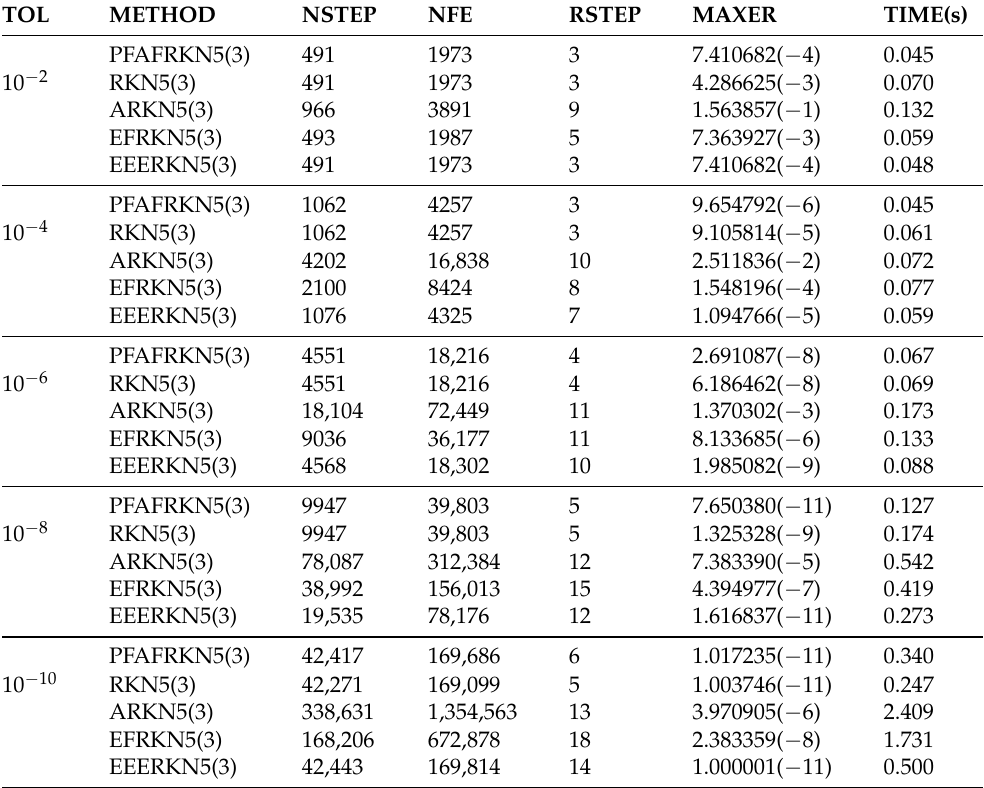
Table 5. Numerical data corresponding to Problem